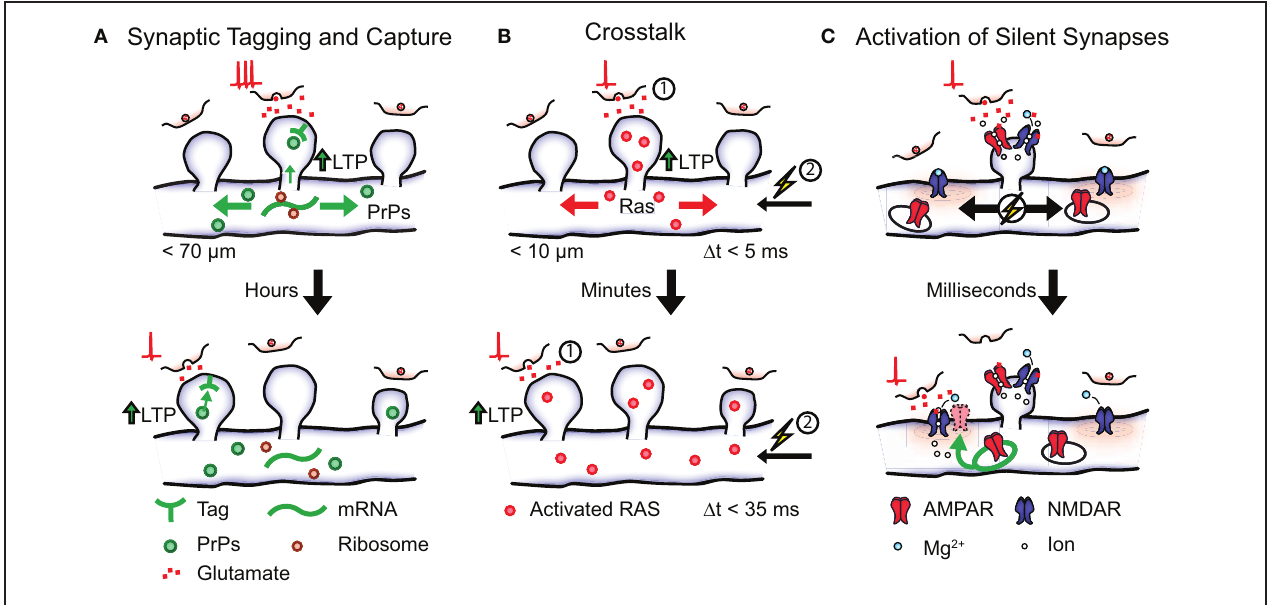
FIGURE 2 | Possible local plasticity mechanisms that establish synaptic clustering. Shown is a local stretch of dendrite containing three synaptic spines. (A) Synaptic tagging and capture. Strong postsynaptic activation leads to the synthesis of plasticity-related proteins (PrPs) that become available in local stretches of dendrite. Synapses tagged within a timescale of hours by weak activation (shown below) can capture plasticity-related proteins in order to express long lasting LTP. (B) Crosstalk. Postsynaptic activation (1) followed by action potential firing (2, spike-timing window < 5ms) leads to the induction of LTP and causes activated RAS from the stimulated spine to spread into the dendrite. The presence of activated RAS